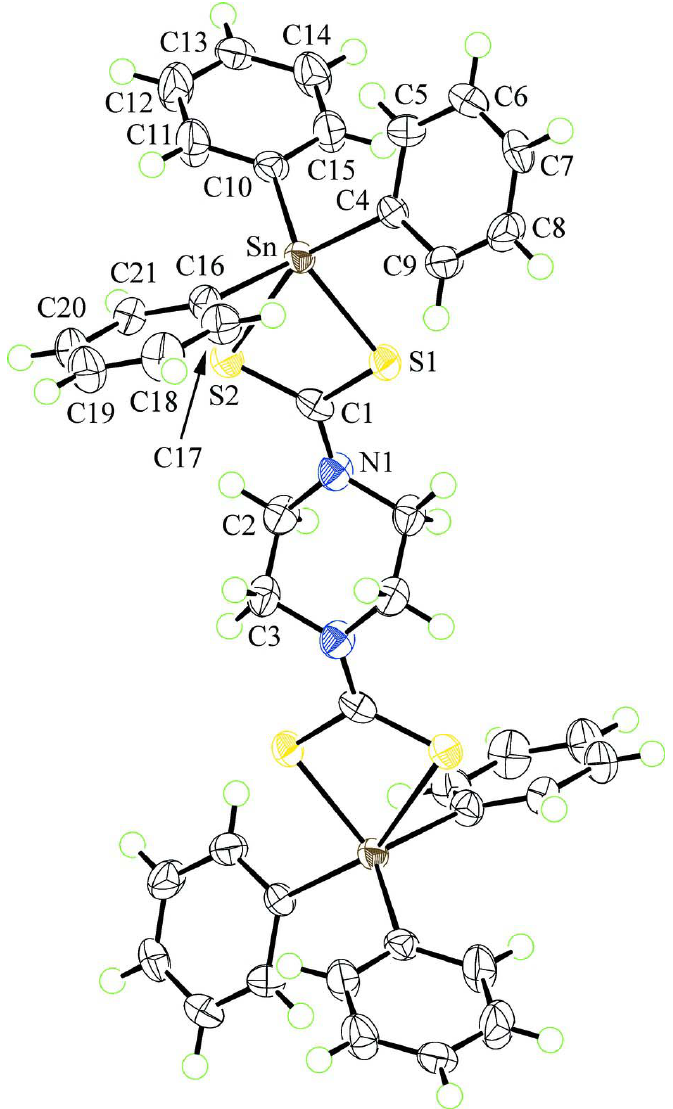
Molecular structure of (I) showing the crystallographic numbering scheme. Displacement ellipsoids are shown at the 70% probability level. Unlabelled atoms are related by the symmetry operation i: -x, 1-y, 1-z. The disordered dichloromethane molecule is